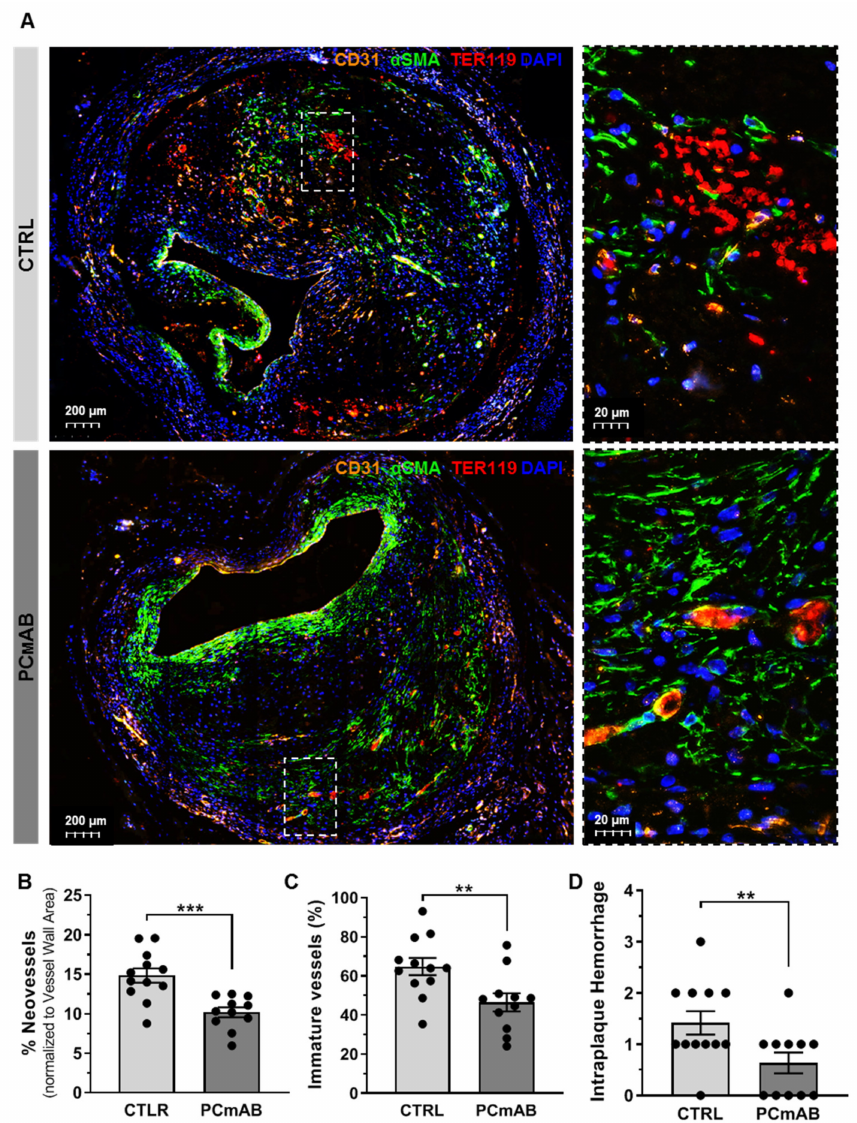
Figure 4. PC-mAb reduces plaque neovessel density and increases vessel maturity, reducing in- traplaque hemorrhage. ( A ) Representative vein grafts cross sections of CD31 (orange), ACTA2 (green), TER119 (red) and DAPI (blue) staining of CTRL and PC-mAb group. Quantitative mea- surements of % Neovessels based on the CD31 staining ( B ) and % Immature Neovessels as shown by the lack of ACTA2 coverage ( C ) and Intraplaque Hemorrhage (Ter119+ erythrocytes outside the neovessel) ( D ) scoring in the CTRL (n = 12) and PC-mAb group (n = 11). Data presented as mean ± SEM. ** p ≤ 0.01, *** p ≤ 0.001 by t -test.